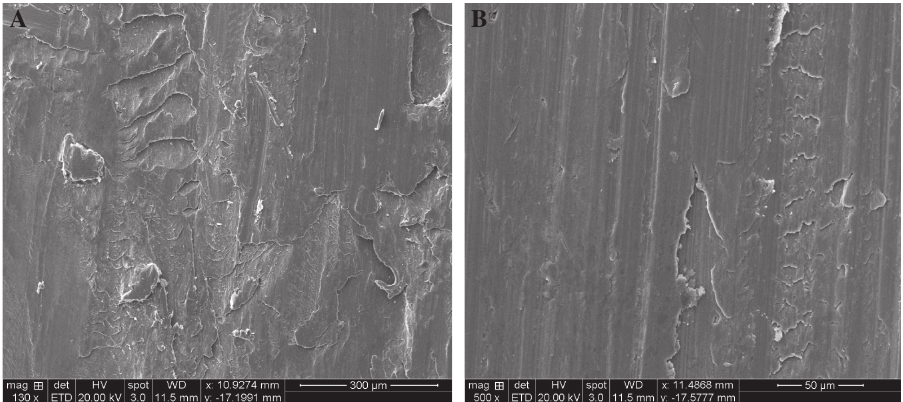
Figure 8 SEM of worn-out surface of MMC with 5% reinforcement.